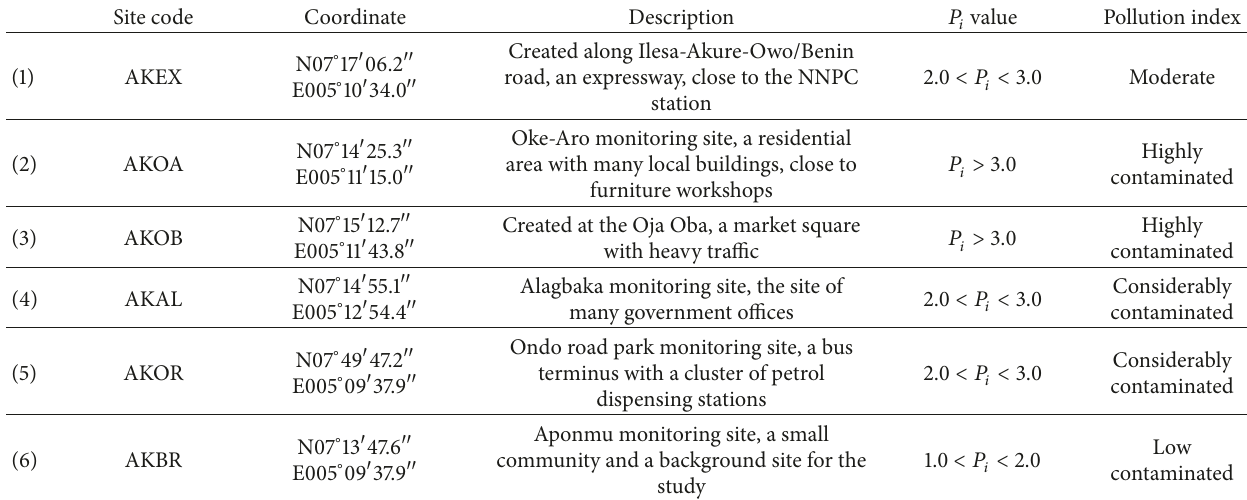
Table 1: Monitoring locations, their characteristics, and coordinates at